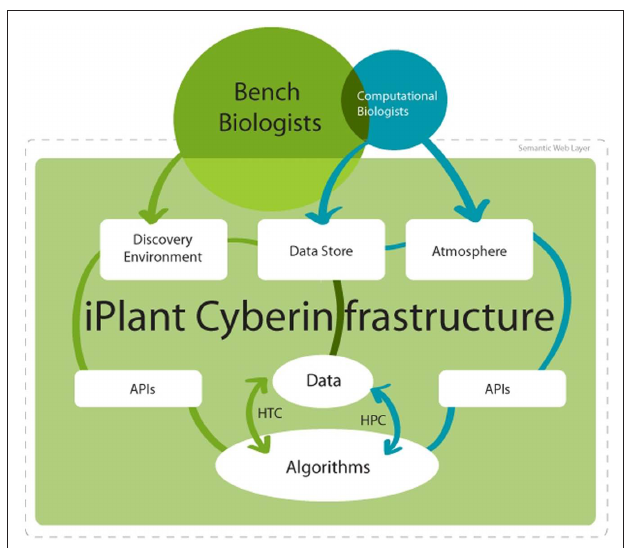
FIgure 1 | overview of access options for iPlant’s major cyberinfrastructure components. iPlant’s CI consists of several major systems, each of which provides a set of computational resources for different types of users. The basic level of services provides access to data and data analysis algorithms. For large datasets, there are two general paradigms for computing: high-throughput computing (HTC) and high-performance computing (HPC). The major difference is that HTC provides rapid access to many different data types requiring discreet computation while HPC provides access to many interlinked compute nodes for tightly coupled parallel computation. Data resides in iPlant’s Data Store, a cloud-based distributed system for storing and sharing large quantities of data that are automatically replicated between iPlant’s major sites. iPlant resources can be accessed directly or through APIs. iPlant’s Discovery Environment is a web-based system and provides functionality to manage data, add new algorithms and tools, and run analyses on appropriate computational resources. Atmosphere is iPlant’s on-demand cloud computing resource that allows users to launch virtual machines, install complex software of their choice, connect to iPlant’s Data Store and other compute resources, and share cloud resources with collaborators. Together, iPlant’s CI proves a wealth of interconnected computational and data management resources to users with different needs and diverse levels of computational